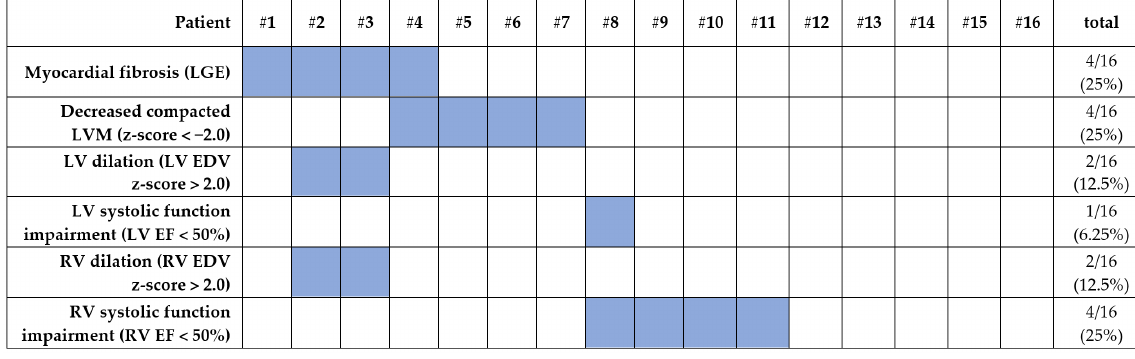
Figure 1. Prevalence of ventricular abnormalities in the LVNC group as detected in CMR.